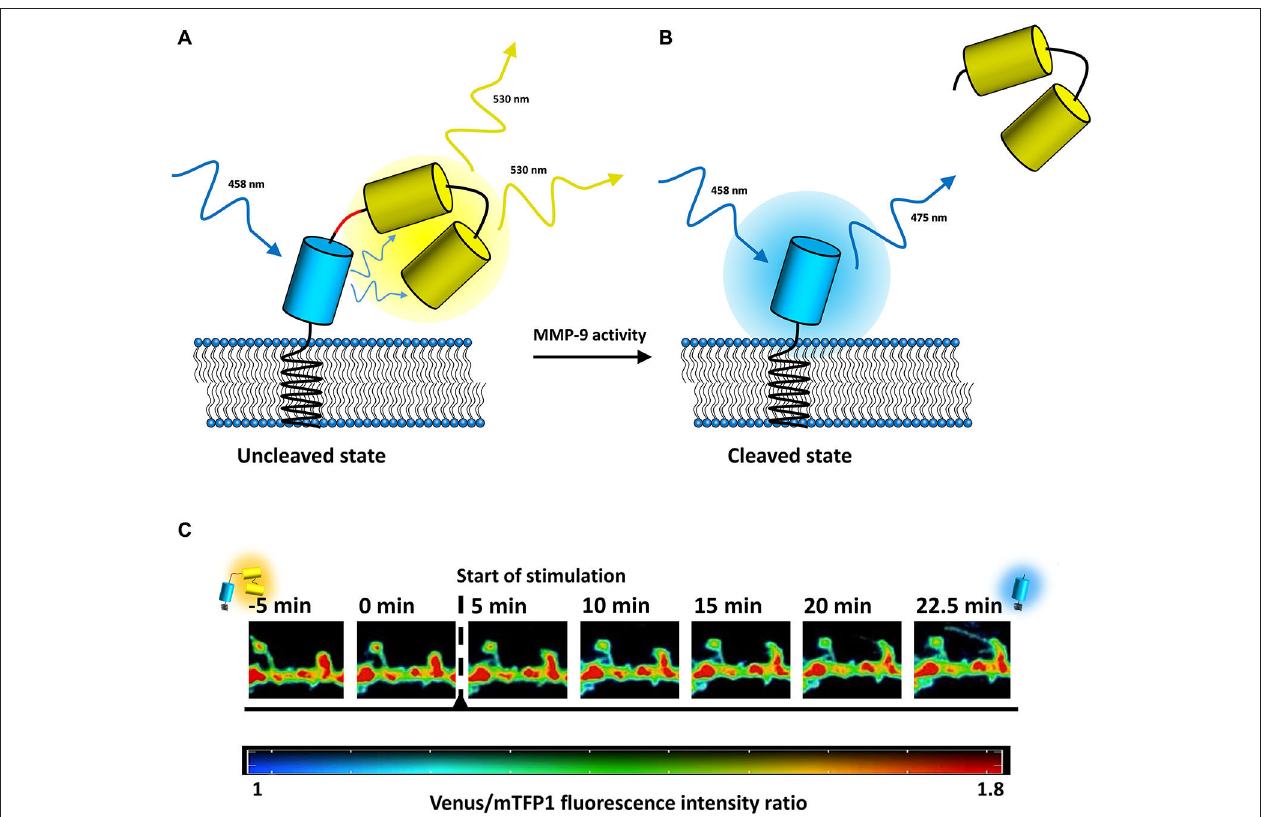
MMP-9 activity biosensor expressed in a primary rat hippocampal culture. Colors indicate the value of Venus-to-mTFP1 fluorescence intensity ratio (reds—high values of the ratio/uncleaved biosensor; blues—low values of the ratio/cleaved biosensor; see the color bar below image insets). Stimulation was performed with the chemical long-term potentiation (LTP) protocol (see Stawarski et al., 2014). Biosensor pictures in the left and right of the diagram indicate visually the state of the biosensor